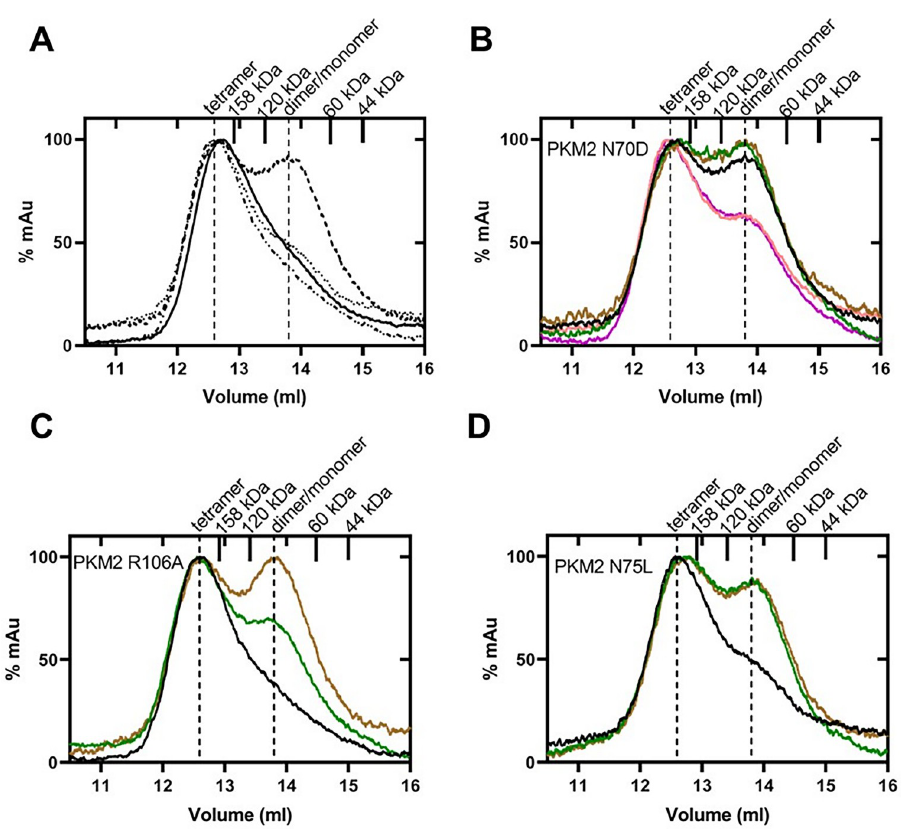
Fig 4. Gel filtration chromatograms of wtPKM2 and PKM2 variants in the absence and presence of AAs demonstrating the differential effect of AAs. (A) The profiles show that PKM2 N70D (—) exist as a clear mixture of tetramer and dimer/monomer equilibrium, wtPKM2 ( − )/PKM2 R106A ( ⸱⸱ − ) exist as tetramers, and PKM2 N75L ( ⸱⸱⸱ ) has some dimer/monomer fraction. (B) The oligomeric state of PKM2 N70D becomes predominantly tetrameric upon incubation with Asn/Asp but remains as an equilibrium of tetramer and dimer/monomer mixture with Val/Cys (green/brown trace). (C) PKM2 R106A and (D) PKM2 N75L exist primarily in the tetrameric state and upon addition of Val/Cys shift to an equilibrium mixture of tetramer and dimer/monomer. The standards (158 kDa and 44 kDa) and theoretical molecular weight of dimer (120 kDa) and monomer (60 kDa) are marked as ticks on the upper axis. Colors: Chromatograms of PKM2 variants in the absence (black) and presence of Asn (magenta), Asp (salmon), Val (green), and Cys (brown). The concentrations of each enzyme and AAs were kept constant at 0.1 mg/ml and 10 mM,